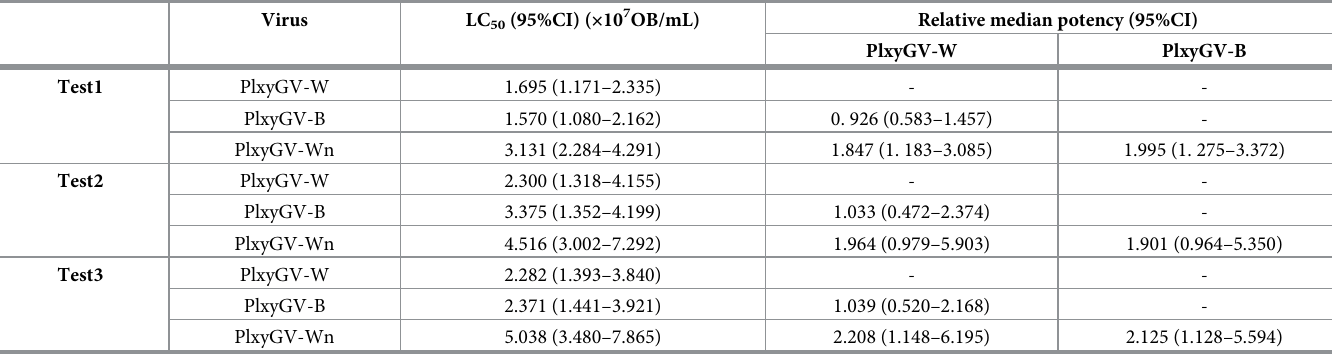
Table 3. Concentration-mortality of PlxyGV-W, PlxyGV-B and PlxyGV-Wn for Plutella xylostella larve.